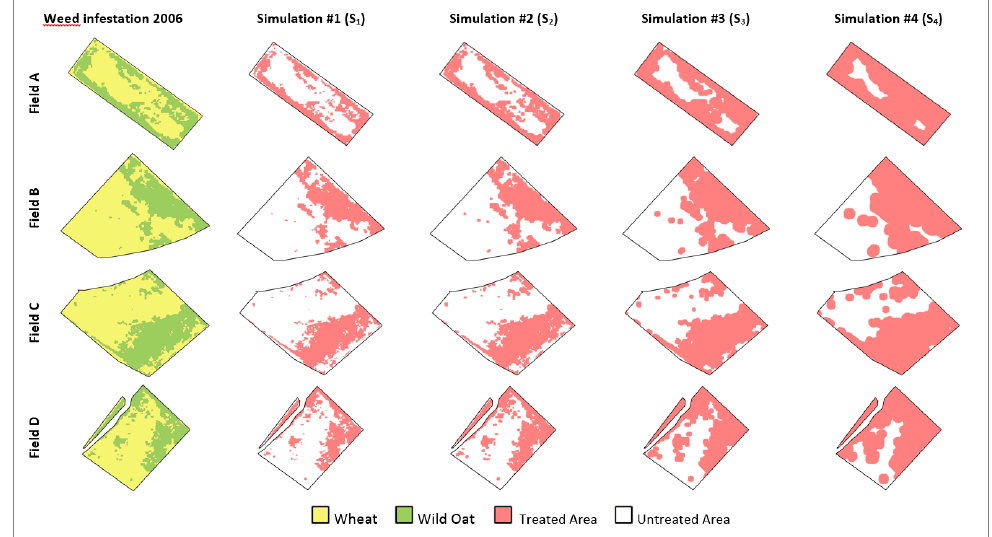
Figure 5. Spatial distribution of the wild oat infestation in 2006 and treatments proposed for the four studied fields. Buffer area considered as infested in each treatment: (S 1 ) 0 m, (S 2 ) 1 m, (S 3 ) 4 m, (S 4 ) 9 m around wild oat patches in the 2006 image.